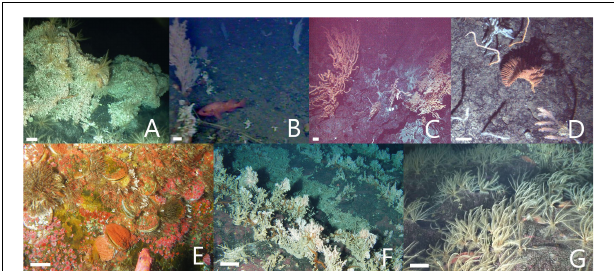
FIGURE 7 | Examples of potential vulnerable marine ecosystems (VMEs): biogenic habitats typified by a variety of biological structures, all of which are VME indicator taxa adopted by one or more regional fisheries management organizations (RMFOs; see Table 1 ) and within the fishing footprint. (A) Mixed gardens including stony coral bioherms ( Desmophyllum pertusum ). (B) Diverse forests including soft corals and others ( Primnoa pacifica , Desmophyllum dianthus , Stylaster spp.). (C) Aggregations of soft corals ( Keratoisis spp. A). (D) Diverse clusters of soft and black corals ( Heteropolypus ritteri, Keratoisis sp. B, Bathypathes sp., Lillipathes lillei , Chrysopathes speciosa ). (E) Epifauna-encrusted mats of giant scallops ( Crassadoma gigantean ). (F) Vast fields of hydrocorals ( Stylaster spp.). (G) Dense aggregations of crinoids ( Florometra serratissima ) hiding barely visible small rockfish ( Sebastes spp.). Most images are side-view (from the ROV on the pinnacle or summit plateau) with the exceptions of (C,D) , which are downward-facing (from the AUV on the flanks). (B) Is a lower quality side-view (from the aborted dive SFU 2 at the summit ridge). White scale bars =10 cm.